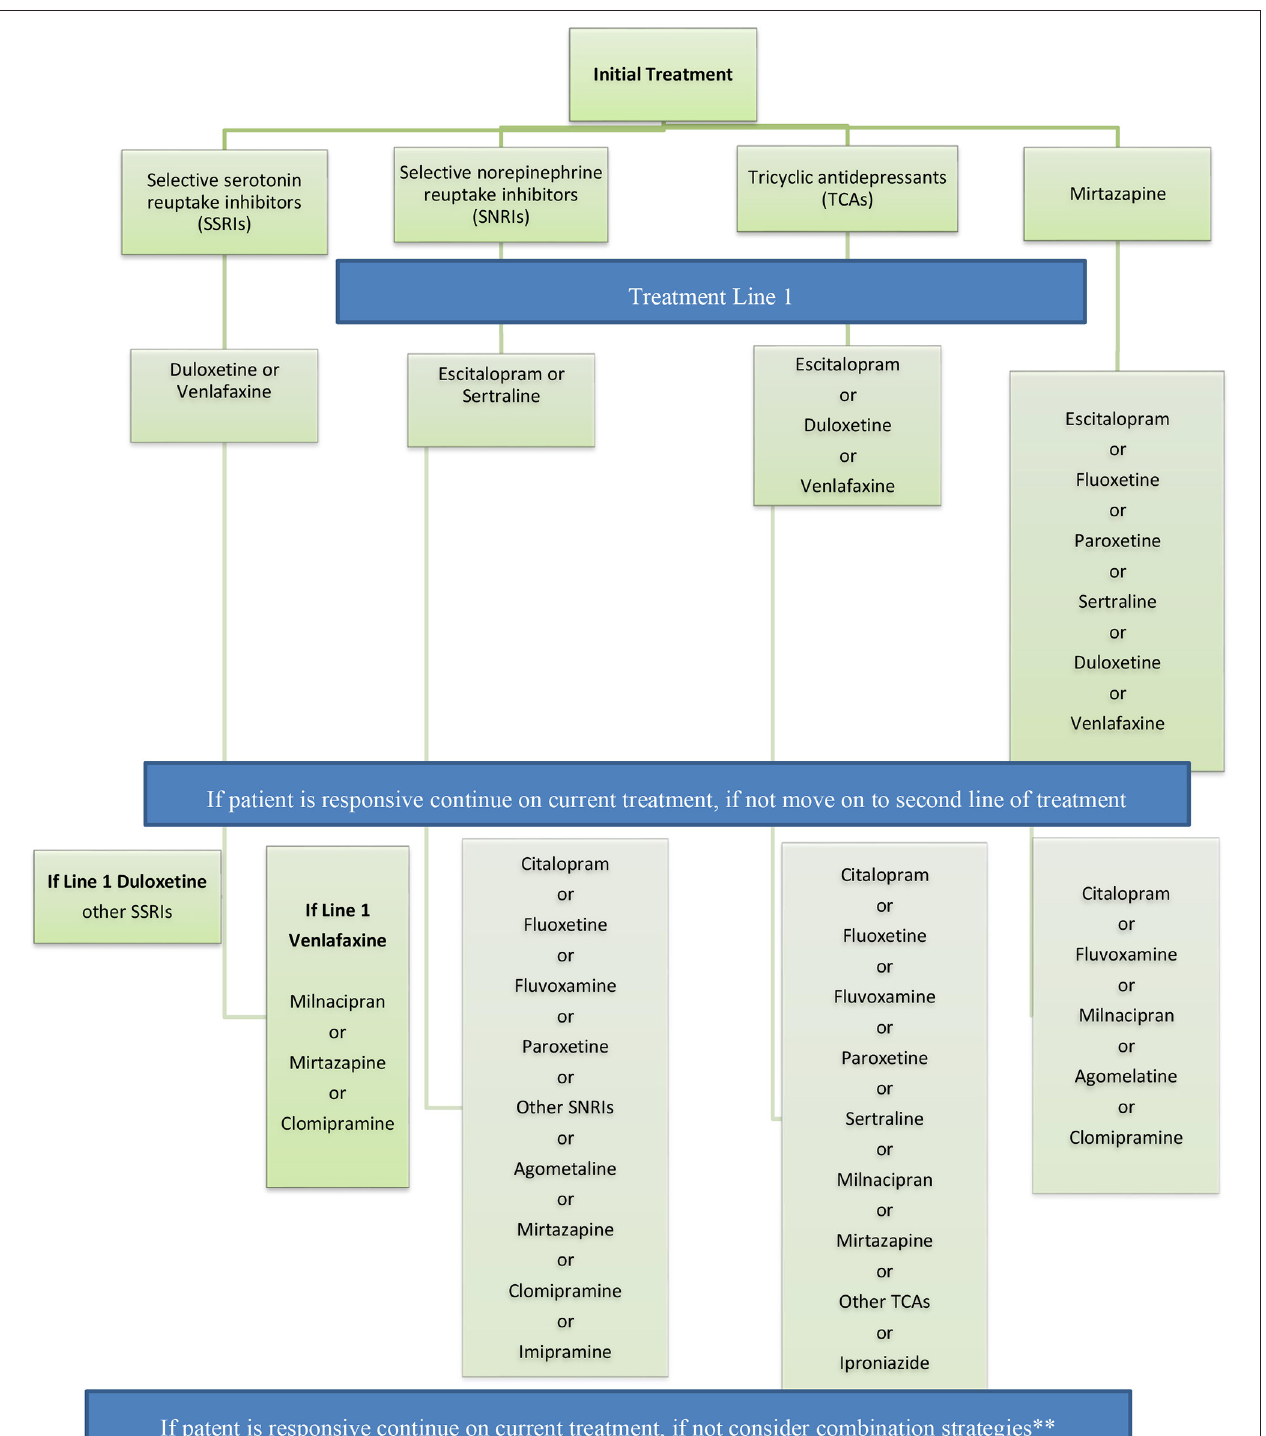
FIGURE 3 | Recommendations for switching antidepressant medications. If patient is responsive continue on current treatment, if not consider combination strategies** Adapted from the French guidelines. ** Combination strategy = The panel recommends the use of combination strategy in patients with partial response after adequate treatment with a medication for a period of 2–4